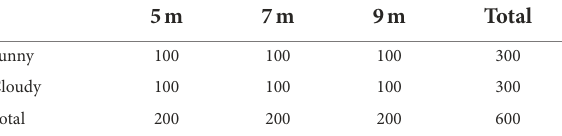
TABLE 1 Original UAV image data distribution of residual film in cotton field.